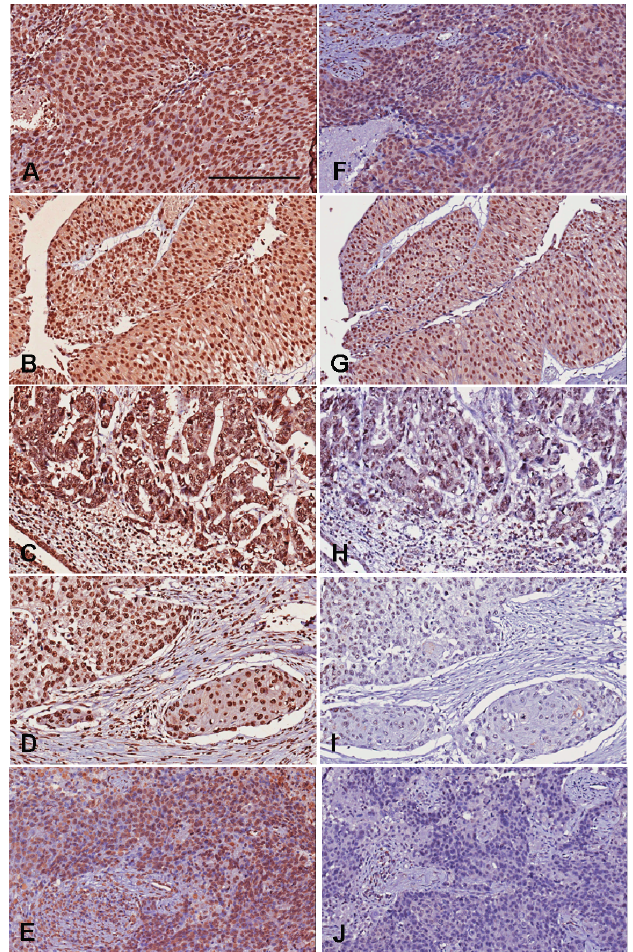
Figure 2. Representative photography of 5-MeC and DNMT1 immunohistochemistry. The 5-MeC photography in A – E ; The DNMT1 photos in F – J . ( A , F ) High-grade urothelial carcinoma showing high levels of both 5-MeC and DNMT1; ( B , G ) Low-grade urothelial carcinoma showing high levels of both 5-MeC and DNMT1; ( C , H ) High-grade urothelial carcinoma with glandular differentiation, showing high 5-MeC but low DNMT1 levels. ( D , I ) High-grade urothelial carcinoma with squamous differentiation, showing low levels of both 5-MeC and DNMT1; ( E , J ) High-grade urothelial carcinoma showing low levels of both 5-MeC and DNMT1. Bar = 200